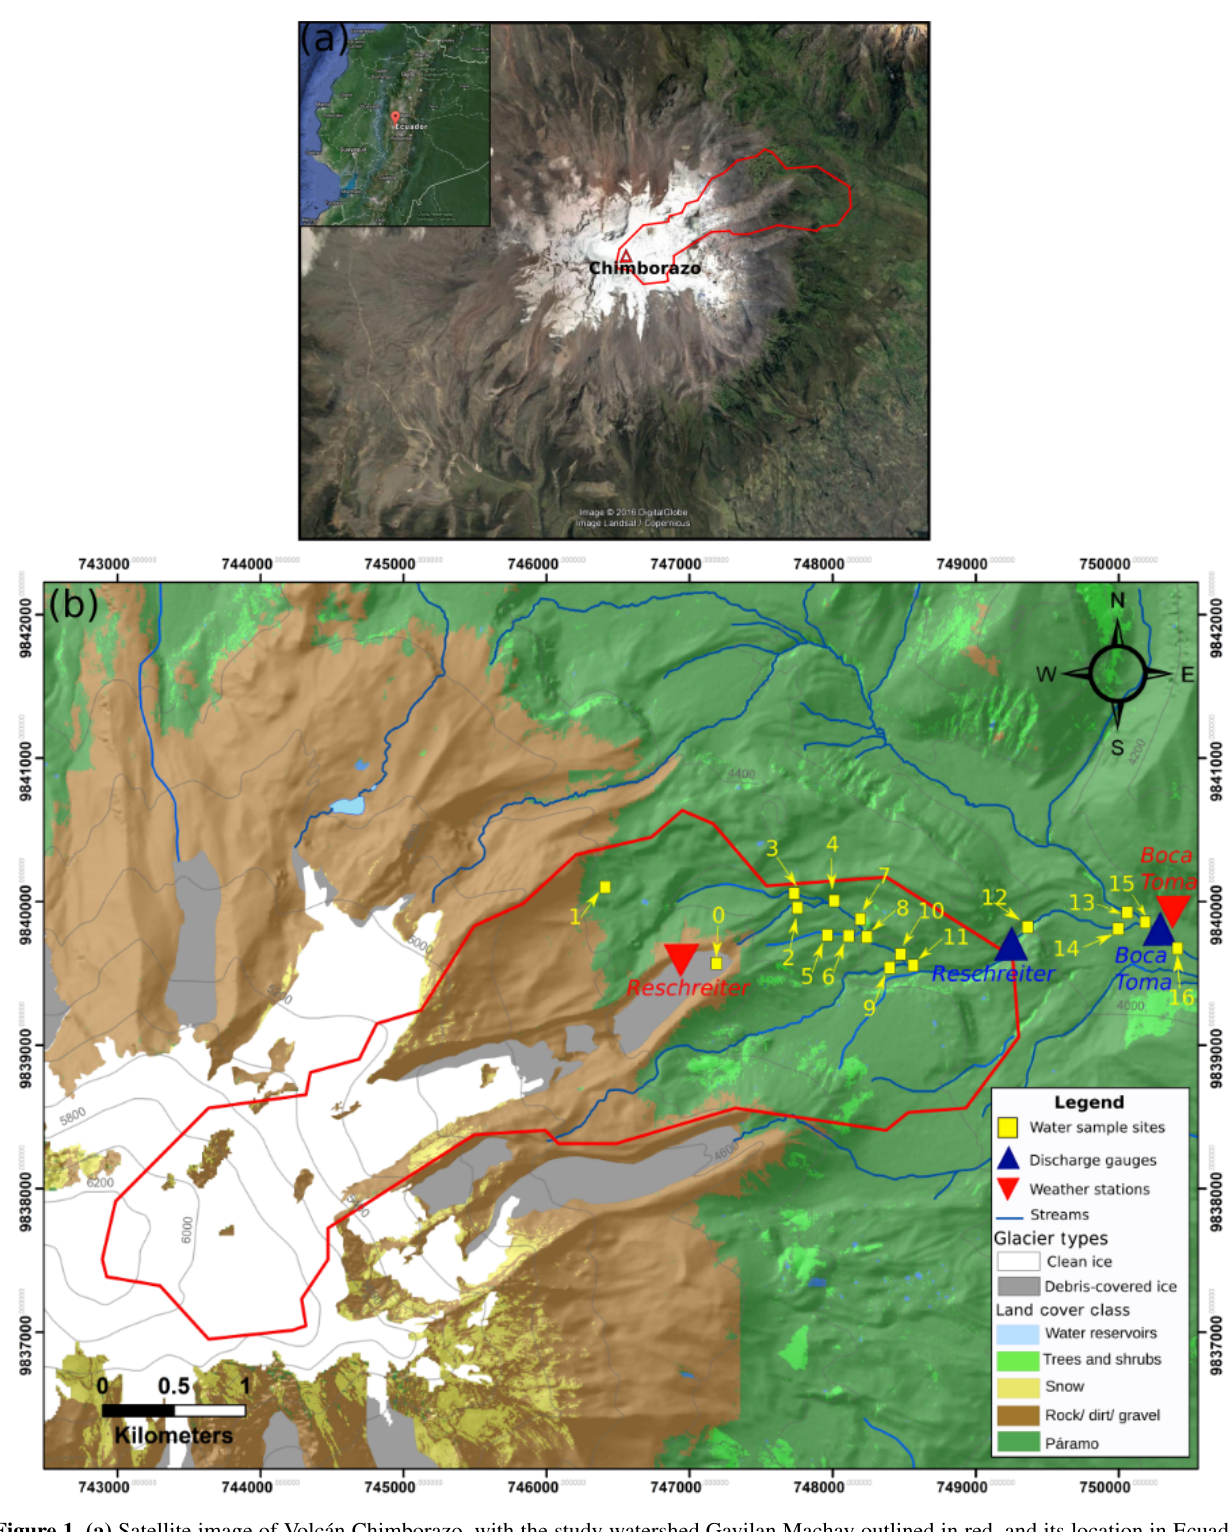
Figure 1. (a) Satellite image of Volcán Chimborazo, with the study watershed Gavilan Machay outlined in red, and its location in Ecuador shown in the inset map. The glacierized Gavilan Machay watershed is a relatively humid watershed compared to the western flank of Chimborazo. (b) Land cover and locations of monitoring stations and water sampling within the Gavilan Machay watershed.